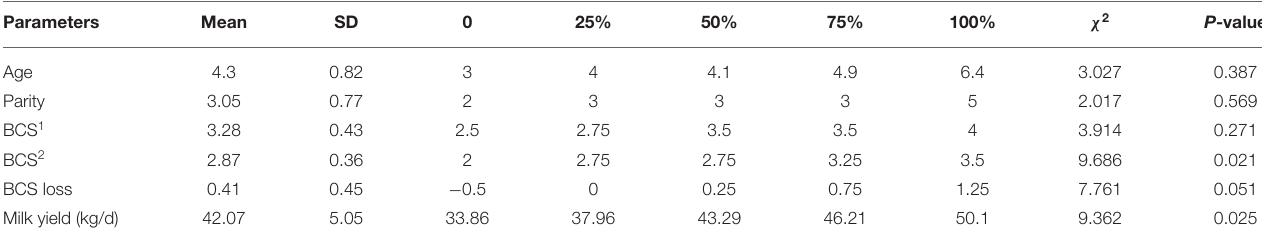
TABLE 1 | Kruskal-Wallis test of general data among the four groups ( n = 76).